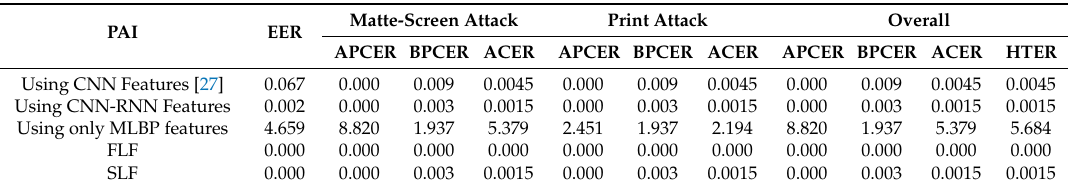
Table 10. Detection errors (APCER, BPCER, ACER, and HTER) of our proposed method with the Replay-mobile dataset using two types of PAI (unit: %). Matte-Screen Attack Print Attack Overall PAI EER Using CNN Features